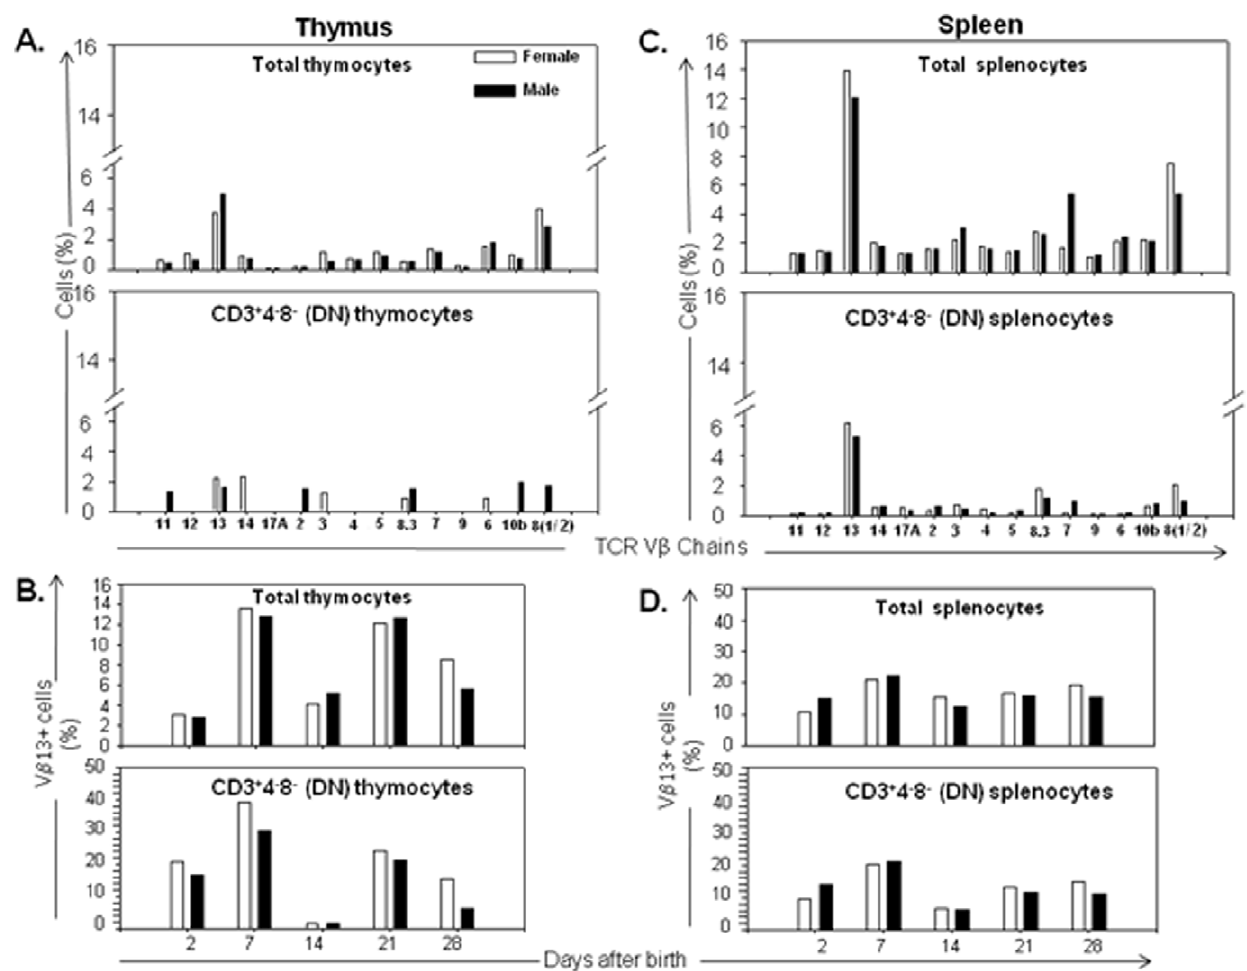
Figure 6. TCR V b repertoire of NOD DNCD3 splenic cells. Single-cell suspensions from the spleen and thymus of 14 day-old NOD female (n=4) and male littermates (n=3) were co-stained with monoclonal antibodies-FITC conjugates specific for several TCR V b -chains and with CD3-PE, CD4-PE- Cy7, and CD8-PerCP mAb-conjugates (Bioscience, Palo Alta, CA). Panel A , percentages of TCR V b families expressed on the cell surface of total thymocytes ( upper panel ) and DNCD3 + gated thymocytes ( lower panel ) as determined by FACS. Panel B , age-variation in the frequency of TCR V b 13 on total thymocytes ( upper panel ) and DNCD3 thymocytes ( lower panel ) from NOD females (n=3 per each group of age) and males (n=3 per each group of age) as determined by FACS. Panel C , percentages of TCR V b families expressed on the cell surface of total splenocytes ( upper panel ) and DNCD3 splenocytes ( lower panel ) from the same mice analyzed by FACS as in panel A. Panel D , age-variation in the frequency of TCR V b 13 on total splenocytes ( upper panel ) and DNCD3 splenocytes ( lower panel ) from the same NOD females (n=3 per group of age) and males (n=3 per group of age) as analyzed by FACS in panel B. Shown is the FACS analysis of a representative NOD female and male from two experiments (significance of V b 13 family expression on DNCD3 cells between two separate experiments, p #